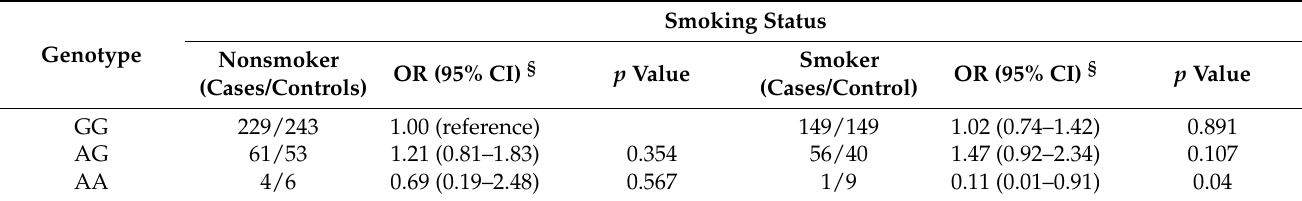
Table 4. Risk of XAB2 rs794078 genotypes with gastric cancer by smoking